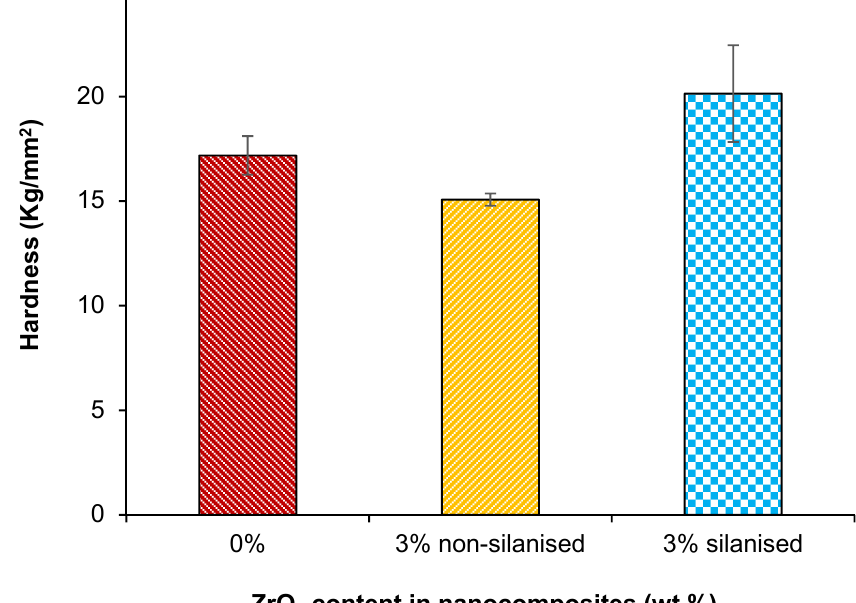
Figure 7. Bar chart showing the effect of treating zirconia nanoparticles on the hardness of the PMMA-zirconia nanocomposites. Table 3. Mean and standard deviation (SD) flexural strength, flexural modulus and Vickers hard- ness values for the test groups.